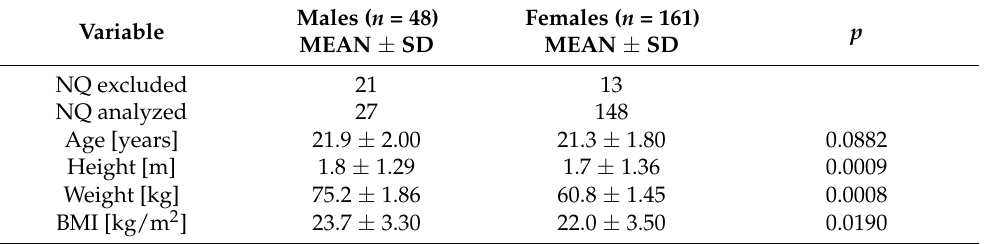
Table 1. The characteristics of the population studied and the number of questionnaires (NQ) analyzed. Males ( n = Variable